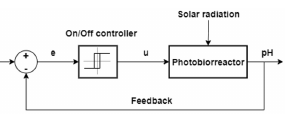
Figure 3. Control scheme of the On/Off control architecture.